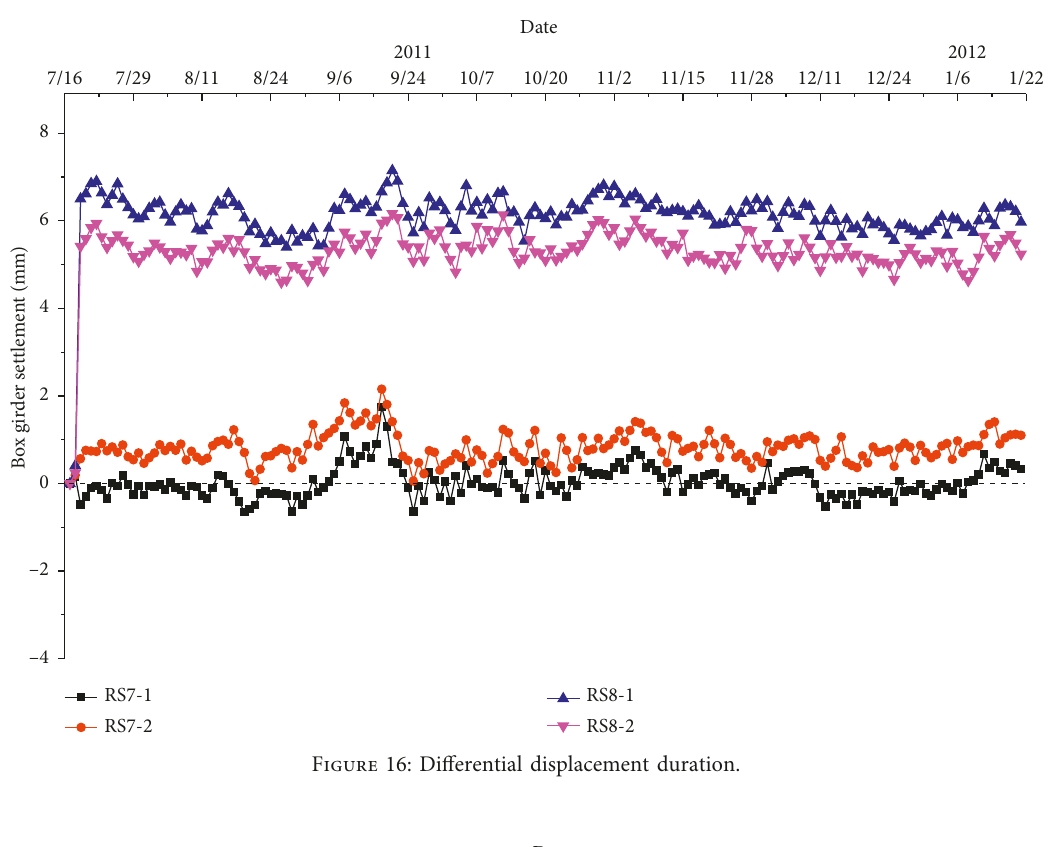
Figure 16: Differential displacement duration.